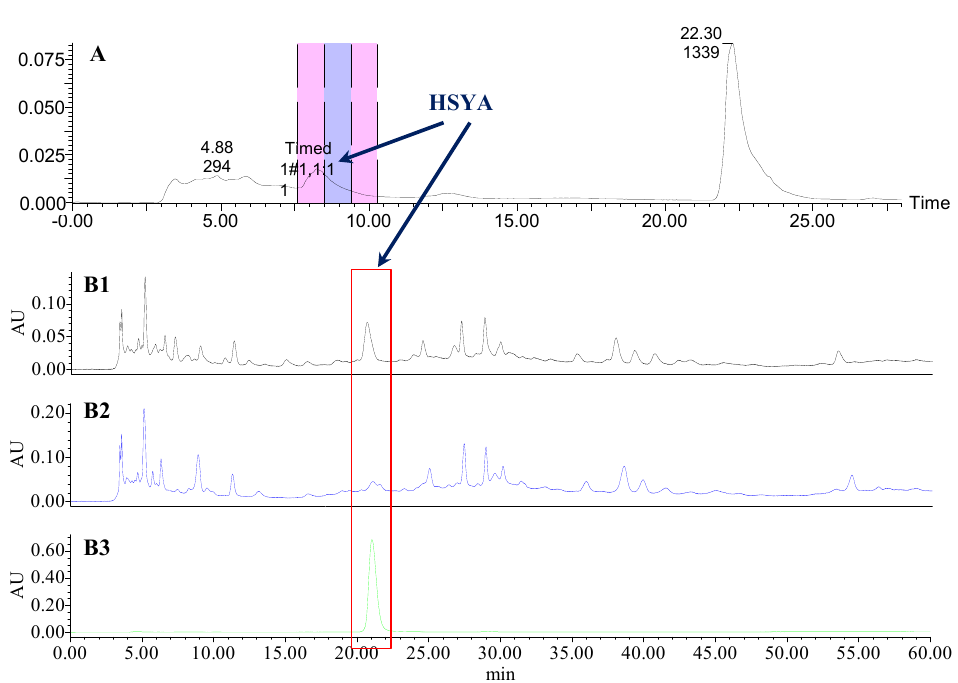
Figure 7. The preparative and analytical chromatograms of the depletion of HSYA from CF-PS; ( A ) preparative chromatogram at 270 nm; ( B1 ) analytical chromatogram of CF-PS at 270 nm; ( B2 ) analytical chromatogram of CF-PS-A at 270 nm; ( B3 ) analytical chromatogram of HSYA depleted from CF-PS at 270 nm.